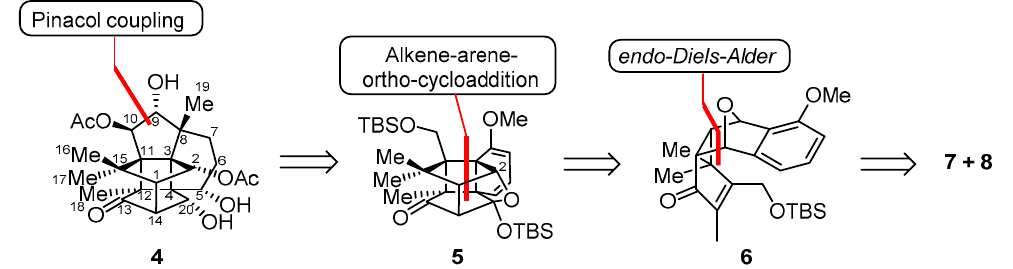
Figure 3. Structure of canataxpropellane ( 4 ) and Gaich’s retrosynthetic analysis [2].